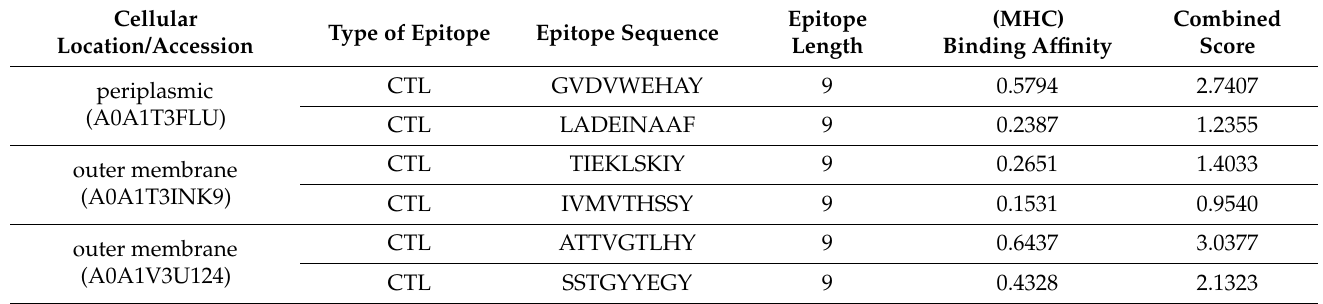
Table 2. The cytotoxic T lymphocyte epitopes predicted for each of the selected proteins of E. meningoseptica, including amino acid sequence, amino acids length, and other parameters.